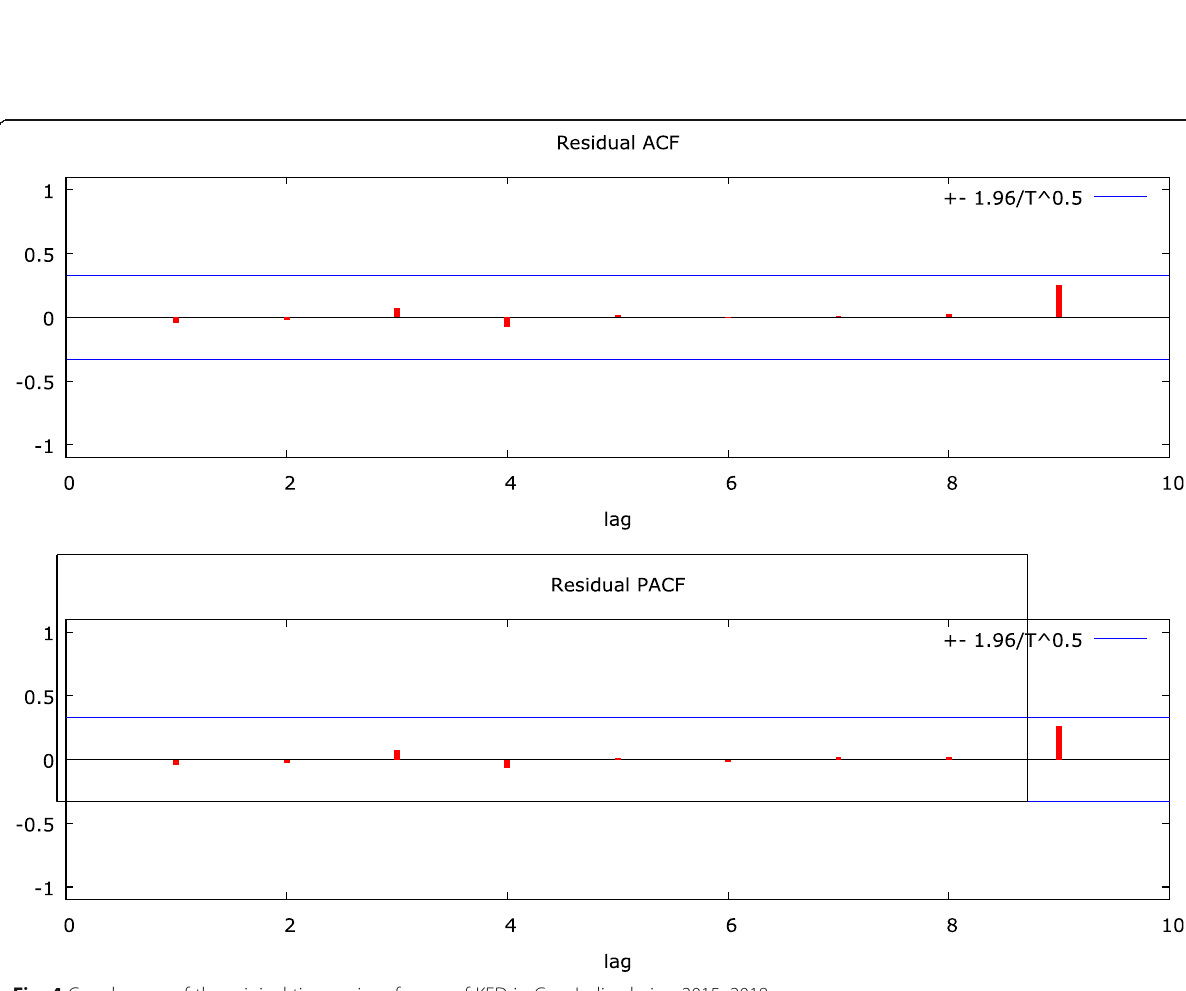
Fig. 4 Correlogram of the original time series of cases of KFD in Goa, India, during 2015 –